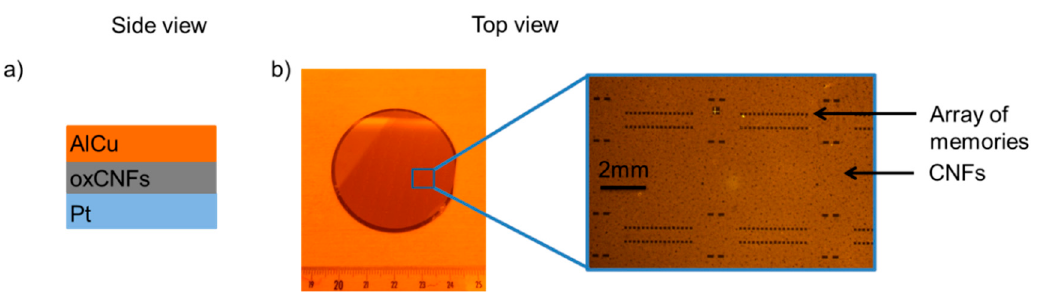
Figure 5. The side and top views of the sample.